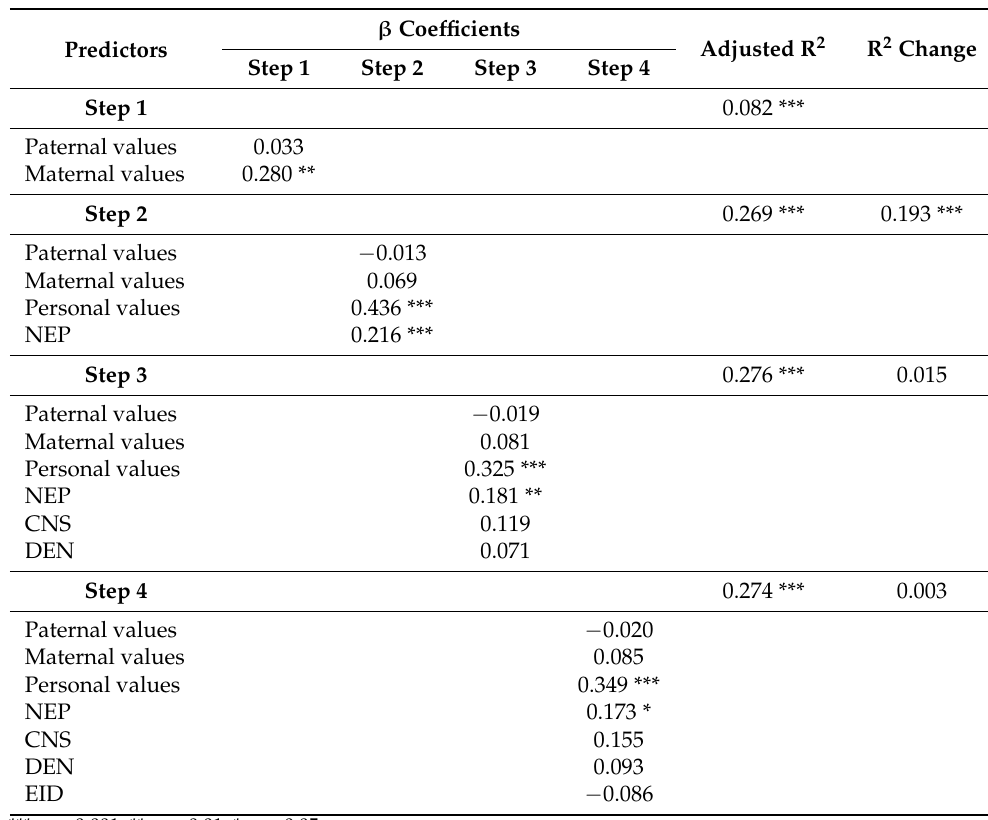
Table 6. HMRA: predictors of recycling and reduced waste production.